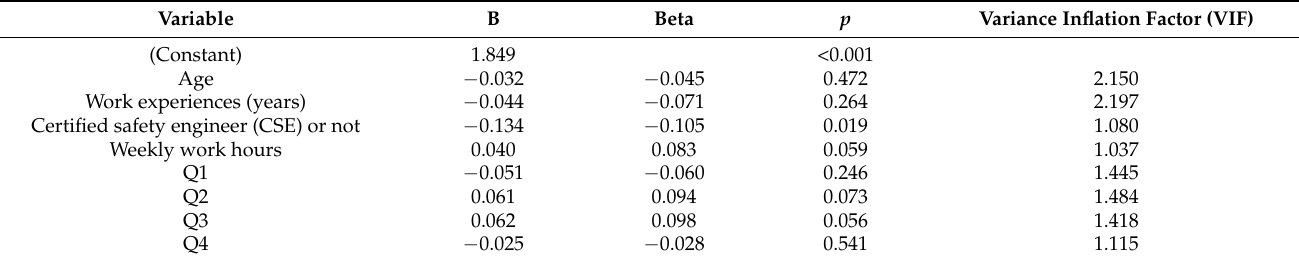
Table 7. Results of regression analysis of OBL.